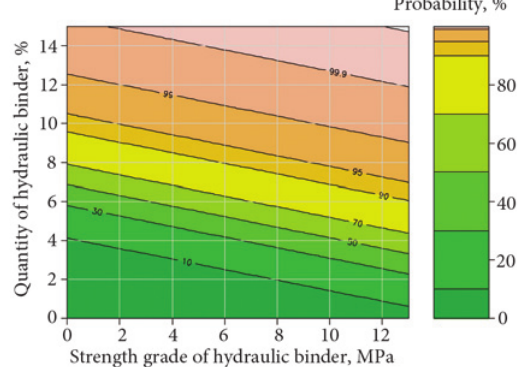
Fig. 4. Contour map of probability of conformity of the compressive strength condition by a soil-binder mixture made from soil No. 1 tested after 90 days (2.5 MPa ≤ R c 42 ≤ 5.0 MPa), with consideration of the frost resistance coefficient n ( n ≥ 0.7)